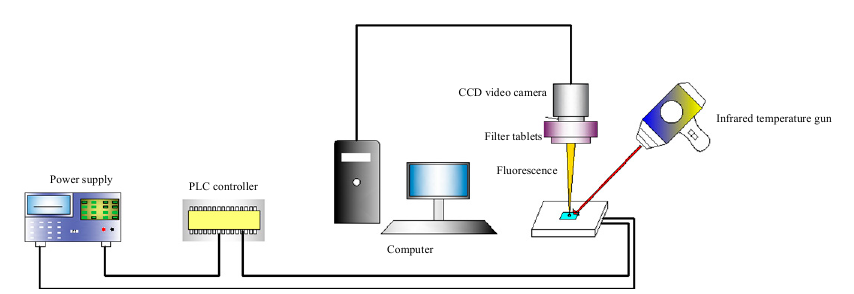
Figure 8. Schematic of fluorescence temperature measurement.